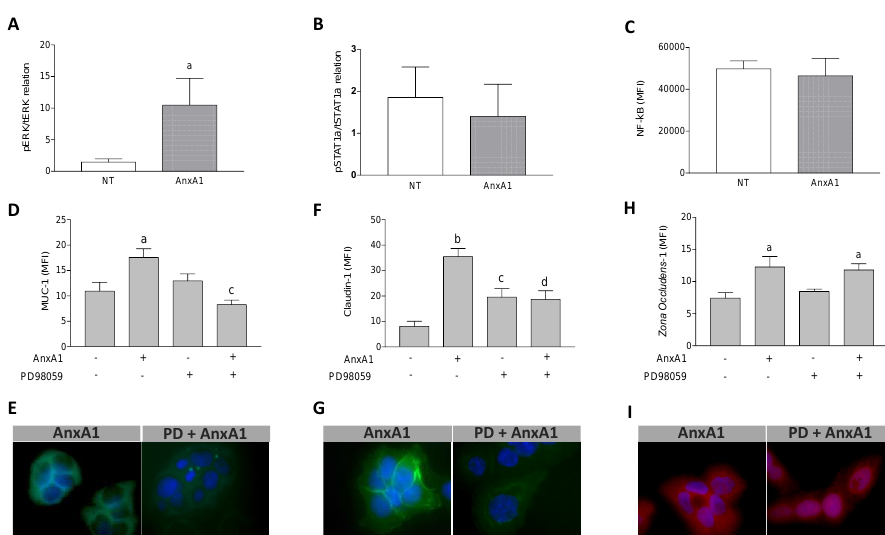
Figure 4. AnxA1 controlled Muc-1 and Claudin-1 expressions on uterine epithelial cells via ERK1/2 phosphorylation. The effect of AnxA1 on ERK ( A ) and STAT1 α ( B ) phosphorylation and NF- κ B expression ( C ) were investigated by flow cytometry. The inhibition on ERK1/2, evoked by PD98059 incubation, was investigated on Muc-1 ( D ), Claudin-1 ( F ) and ZO-1 ( H ) expressions using immunofluorescence. Representative images of Muc-1, Claudin-1 and ZO-1 are shown in ( E ), ( G ) and ( I ), respectively. ( − ) means absence and (+) means presence of treatments. The data are expressed as mean ± standard error of mean of three to five independent experiments. a p < 0.05 and b p < 0.01 vs. NT; c p < 0.05 and d p < 0.01 vs. AnxA1.